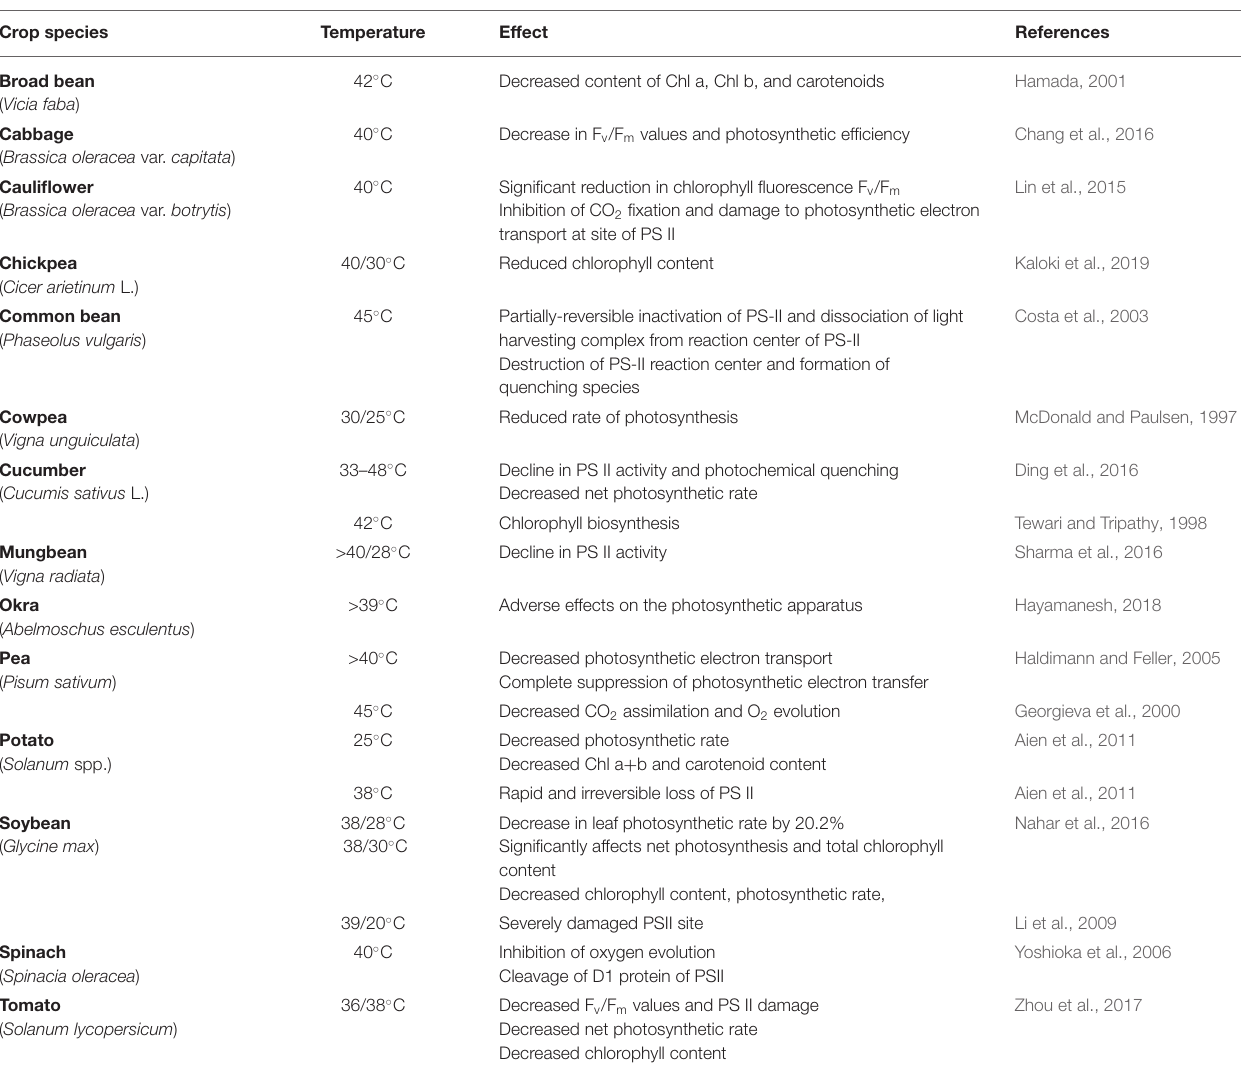
TABLE 4 | Effect of heat stress on photosynthesis in some vegetable